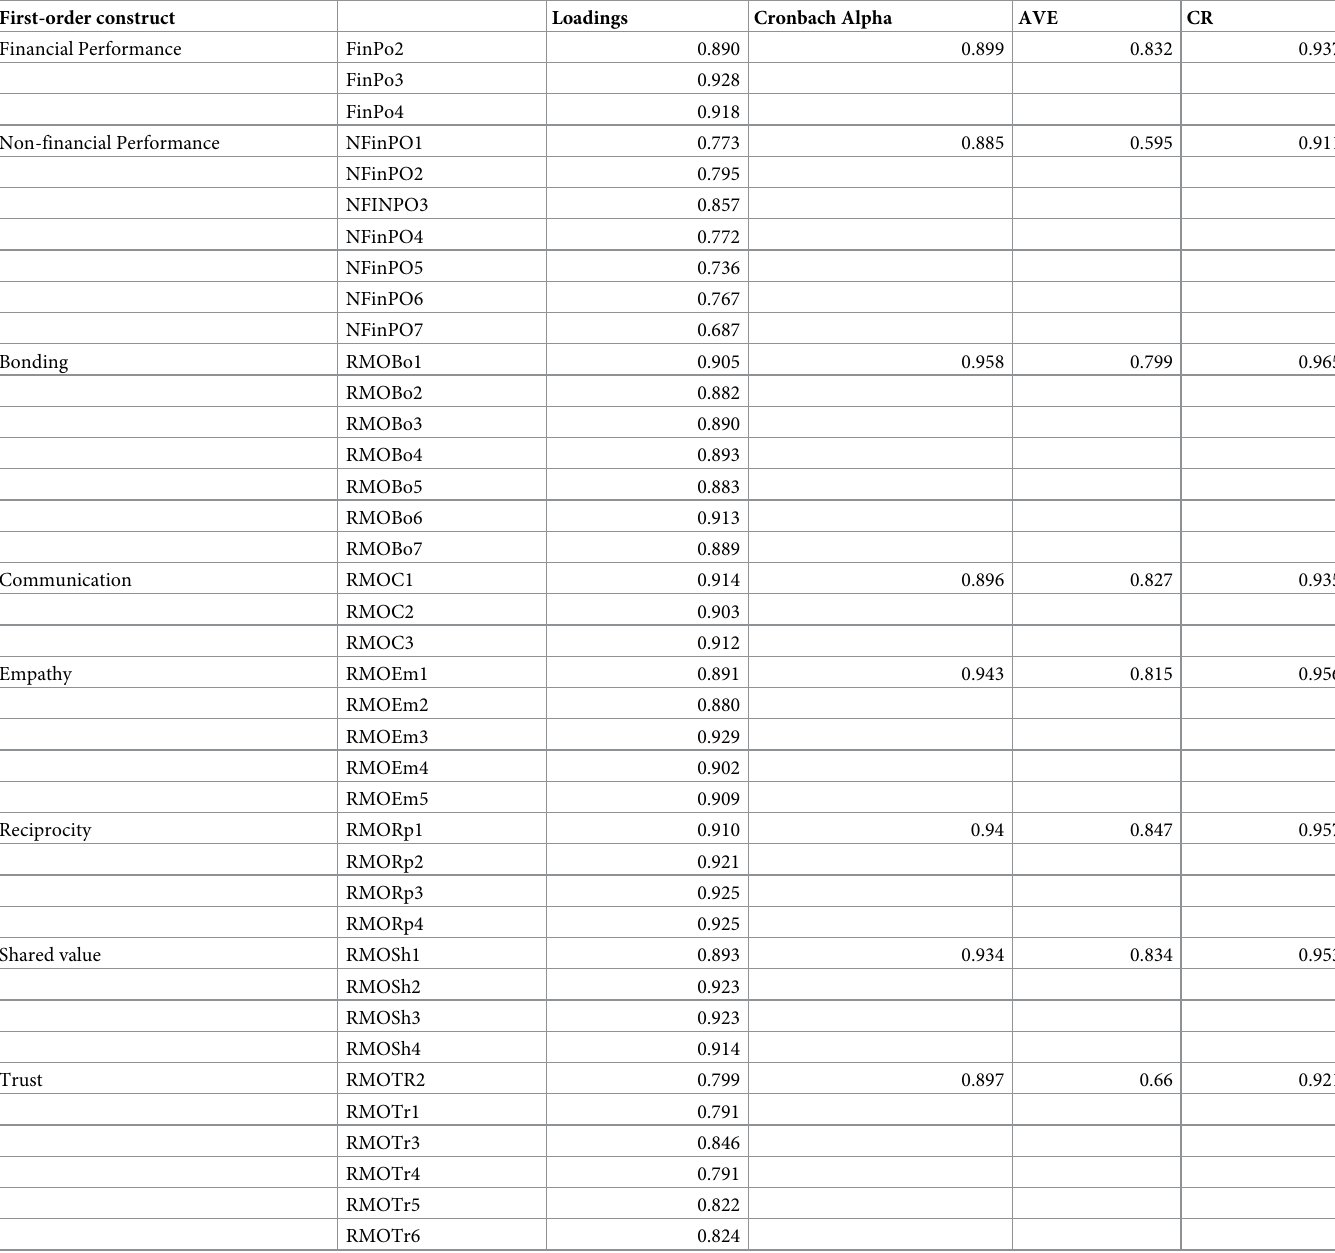
Table 2. Measurement model indicating factor loading, composite reliabilities, Cronbach’s alpha, and average variance extracted (n =